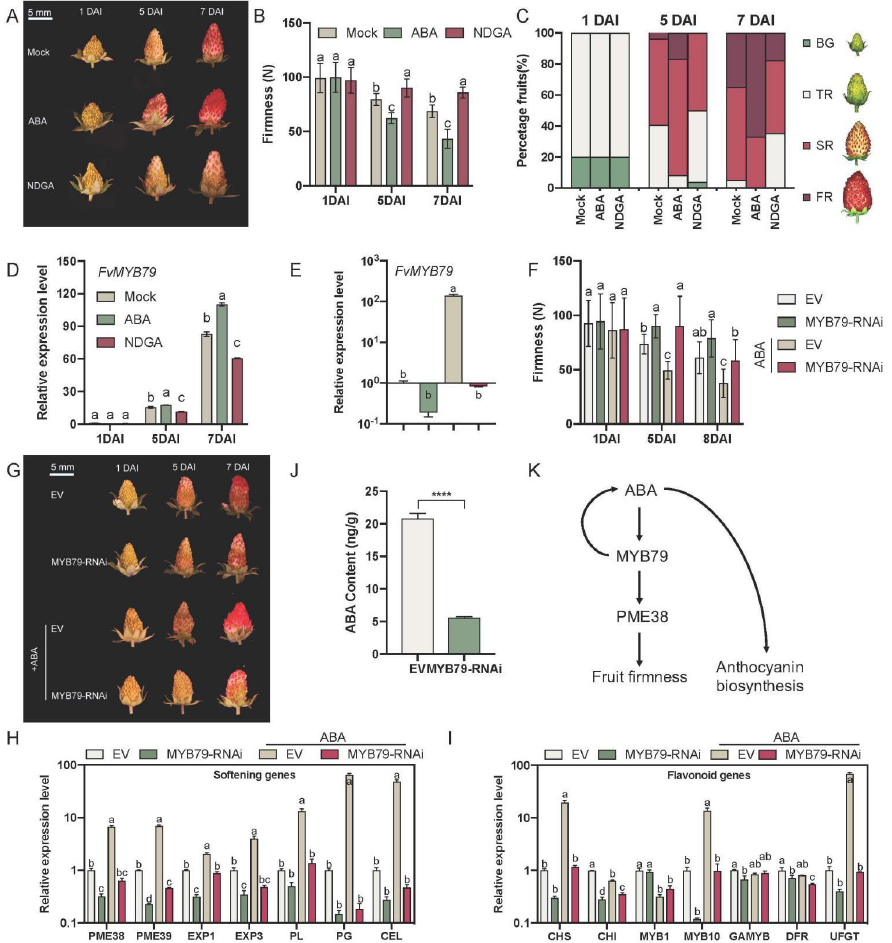
Figure 5. FvMYB79 is involved in ABA-induced fruit softening. ( A ) Phenotypes of fruits were treated with ABA or NDGA (an ABA inhibitor). DAI, day after infiltration. ( B ) Firmness value of fruits after infiltration. The number in bracket of x-axis labels represents the number of days after injection. Error bars represent SD of 15 fruits. Letter indicates significant differences between groups ( p < 0.05, one-way ANOVA, Tukey’s HSD post hoc test). ( C ) Percentage of fruits at each develop- mental/ripening stage for each time point. ( D ) Q-PCR analysis of FvMYB79 expression level in strawberry fruits after five days treatment. Mock, 15 DAP fruits injected with water; NDGA, 15 DAP fruits injected with NDGA (100 μM). Error bars represent SD of three independent replicates. ( E ) Transcript levels for FvMYB79 in control and FvMYB79 -silenced fruits treated with ABA. Error bars represent the SD of three independent replicates. ( F ) The firmness value of fruits after different treatment. Error bars represent the SD of 15 fruits. ( G ) The Phenotypes of fruits were agro-infiltrated with empty vector or FvMYB79 RNAi construct, and treated with ABA. DAI, day after infiltration;